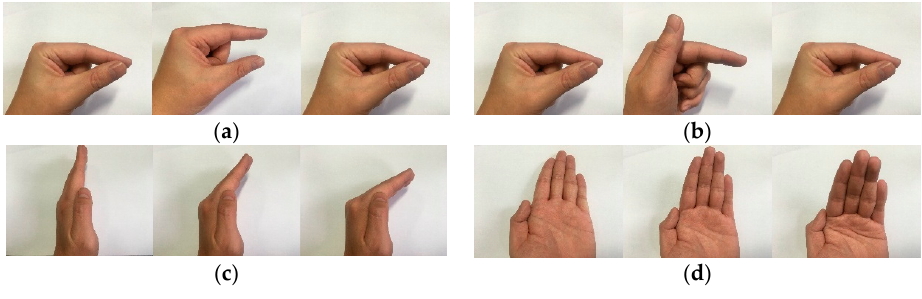
Figure 12. Start, middle, and end points of four gestures. ( a ) Virtual Button; ( b ) Virtual Slider; ( c ) Horizonal Swipe; ( d ) Vertical Swipe.